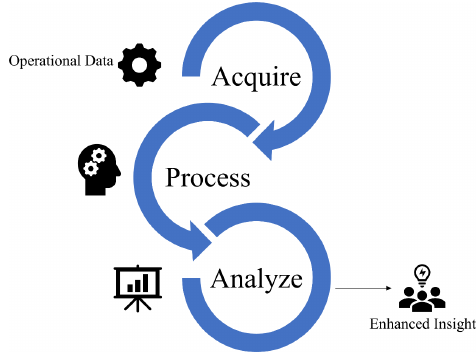
Figure 1: Decision support system for vibration signal